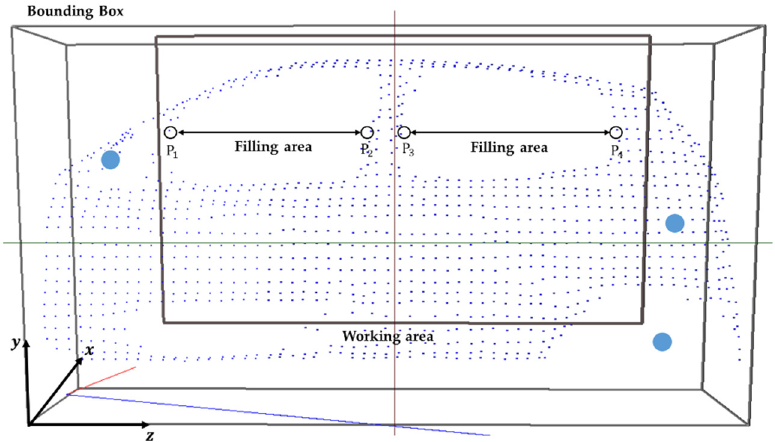
Figure 6. Real automobile body with IR markers.